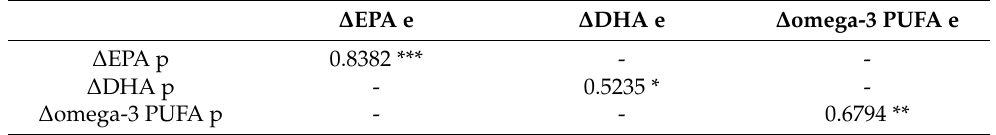
Table 5. Changes in the content of EPA, DHA, and omega-3 PUFA in plasma and erythrocyte phospholipids before and after the treatment (Spearman correlation